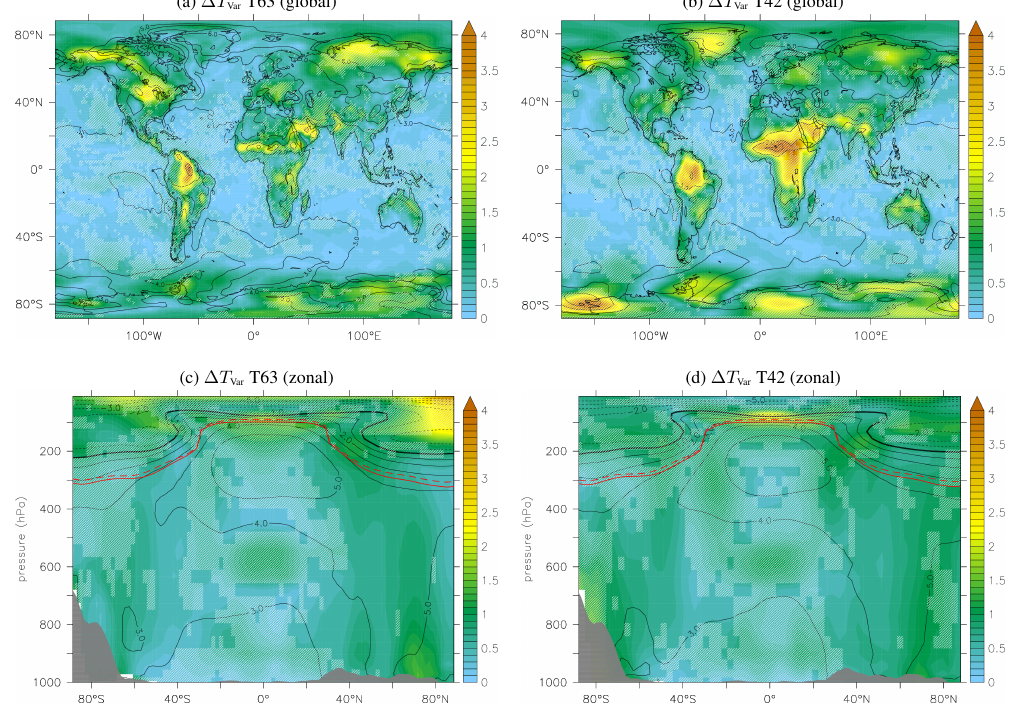
Fig. 3. Maximum error ∆ T Var of the temperature increase in Kelvin (colour coded); The upper panels illustrate regions of high variability for ∆ T for the lowermost model layer, the lower panels show the same for the zonally averaged ∆ T . The black contour lines denote the minimal temperature increase ∆ T min (see Eq. 4) with an interval of 1 K (black solid lines indicate positive and black dashed lines negative values). The red solid and dashed lines depict the averaged tropopause height for the reference- and 2xCO2-simulations, respectively. The white hatched areas show regions where at least 5 of 6 t-tests capture a significant difference of the temperature change between the different convection schemes (see text). In addition, the shift of the tropical tropopause towards 280 lower pressure levels is higher for the resolution T63 while changes in cold point temperatures remain the same. Moreover, Figure 1 (a and c) displays on average a 0.5 K higher temperature increase at the surface and up to 1.5 K in the upper troposphere in comparison with Bitz et al. (2012), 285 suggesting that the warmer baseline climate applied in our REF-simulations explains this difference.